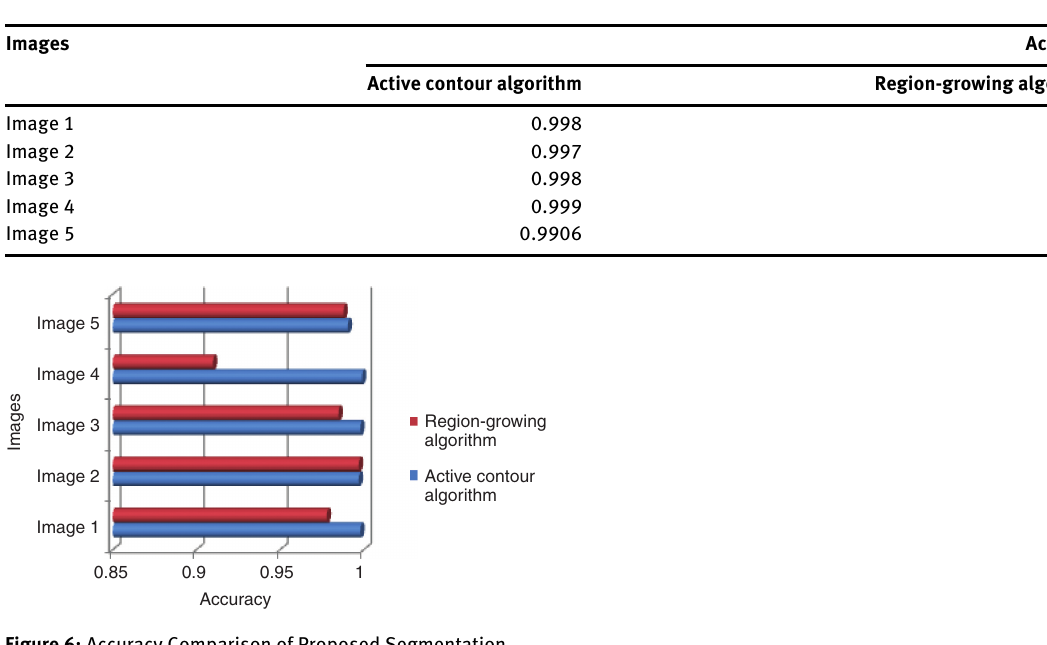
Table 6: Accuracy Comparison of Proposed Segmentation.